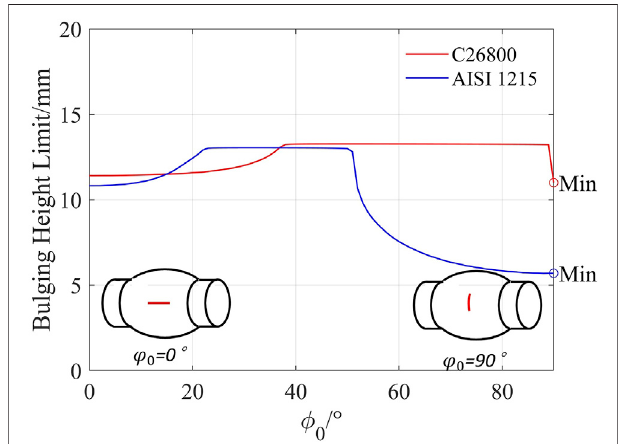
FIGURE 10 | Pole point thickness evolution during the hydro-bulging